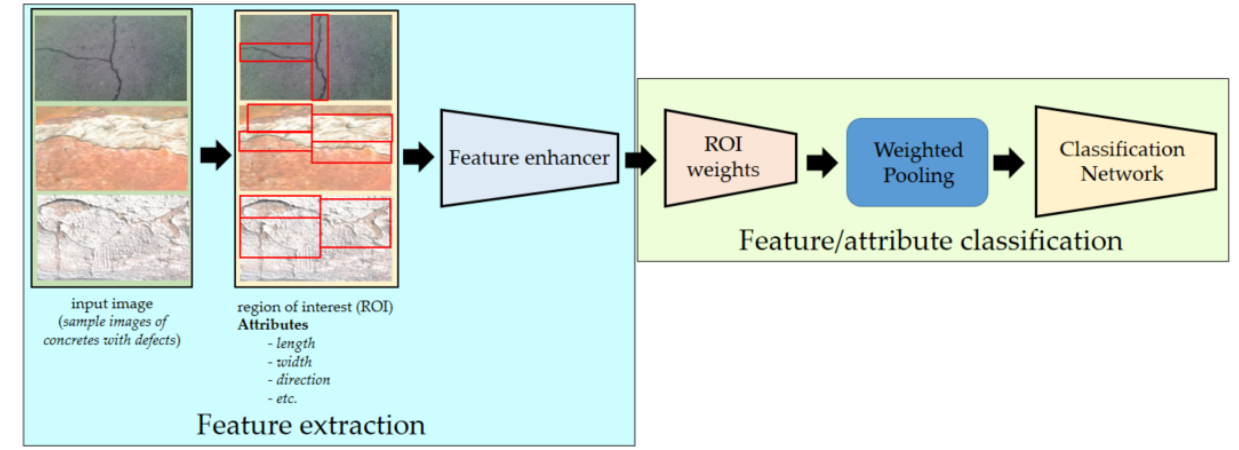
Figure 11. Attention-based network that recognizes multiple objects in an image.